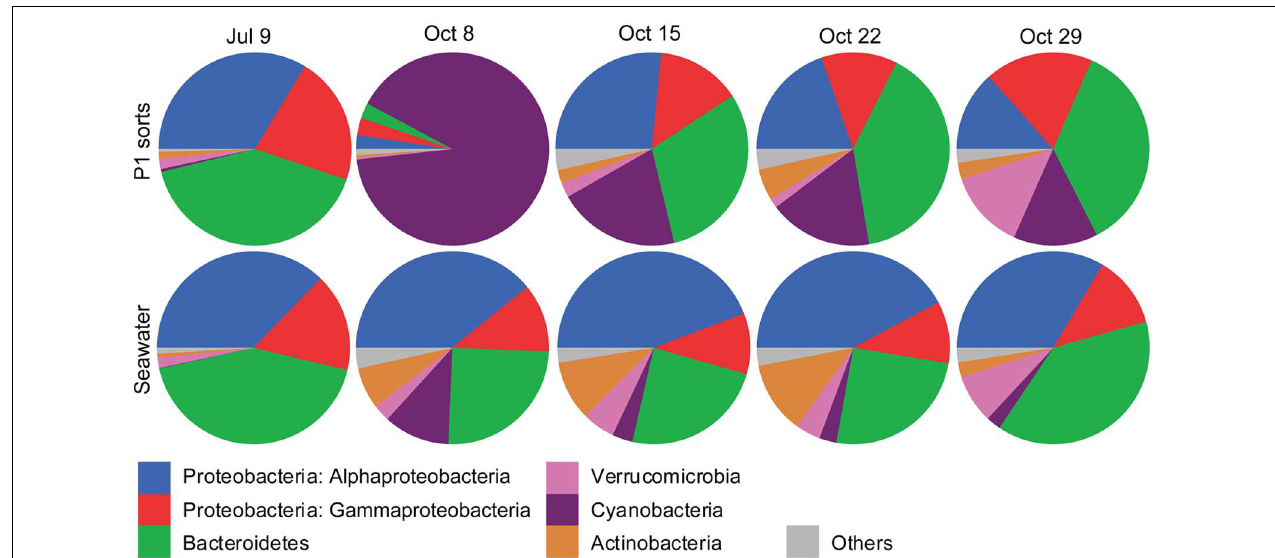
FIGURE 5 | Pie graphs showing the phylogenetic affiliations of non-Eukaryota 16S rRNA gene sequences in photosynthetic picoeukaryote sorts (P1, 1,000 cells), and bulk seawater (0.2–10 µ m) from Illumina MiSeq libraries for each sampling date. The absolute numbers of sequences for the triplicate sort samples from each sampling date have been pooled. The colors for each phyla are indicated below the